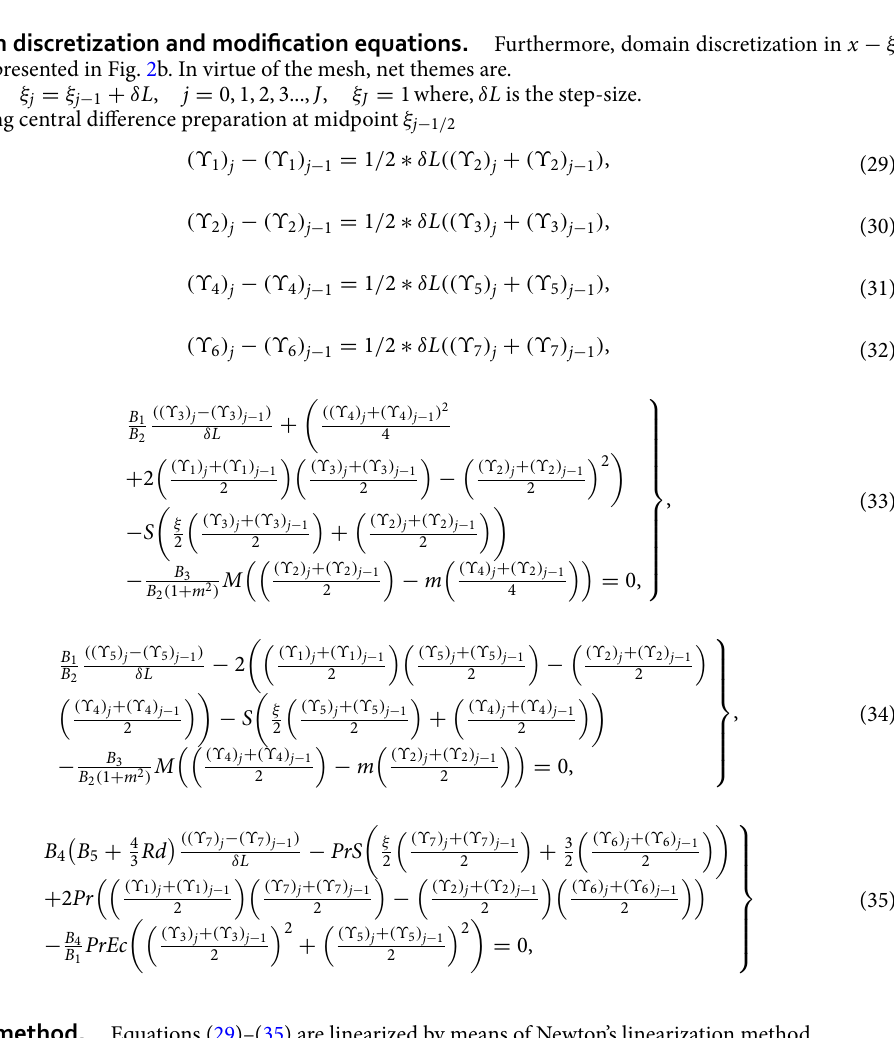
Newton method. Equations (29)–(35) are linearized by means of Newton’s linearization